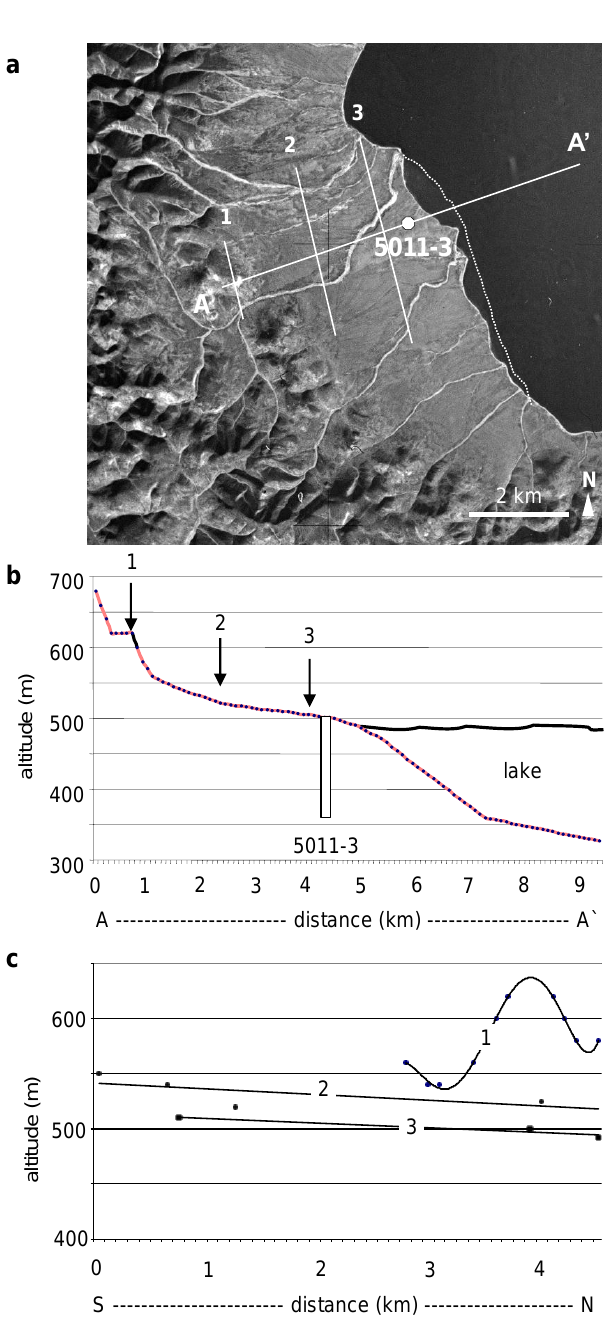
Fig. 2. Topography of the fan surface: a) Enlargement of the subsection in Fig. 1b. Positions of cross profiles 1, 2, and 3 and a radial cross section A- A’ running across the fan delta through the 5011-3 permafrost drill site. The faint dotted line indicates the subaquatic fan prolongation. The delta margin might have been partially flooded after a lake level rise. (Image source: USGS, CORONA 1216-5, acquisition date: 09/14/1980.) b) Longitudinal profile across the drill site. c) Cross profiles 1, 2, and 3.